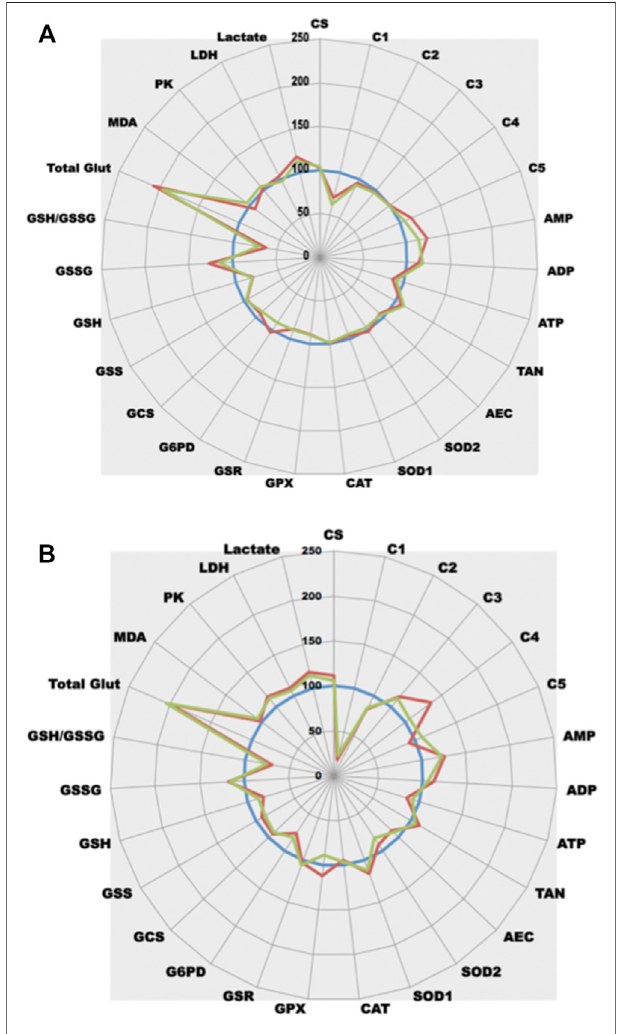
FIGURE 6 | Comparative analysis of the effect of rotenone on cell metabolism. (A) -Rotenone-induced complex I dysfunction in PNT1A cells (blueline,control (cid:1) 100%;greenline,+rotenone 5nM;red line,+rotenone50 nM). (B) -Rotenone effect in an animal model (Caenorhabditis elegans) (blue line, control (cid:1) 100%; green line, + rotenone 50 nM; red line, + rotenone 100 nM).